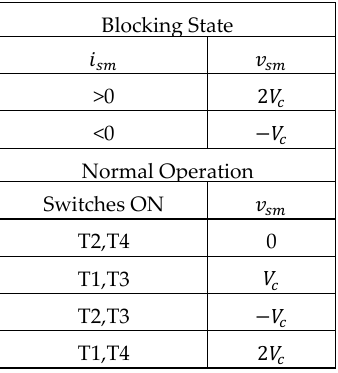
Figure 20. AFBSM